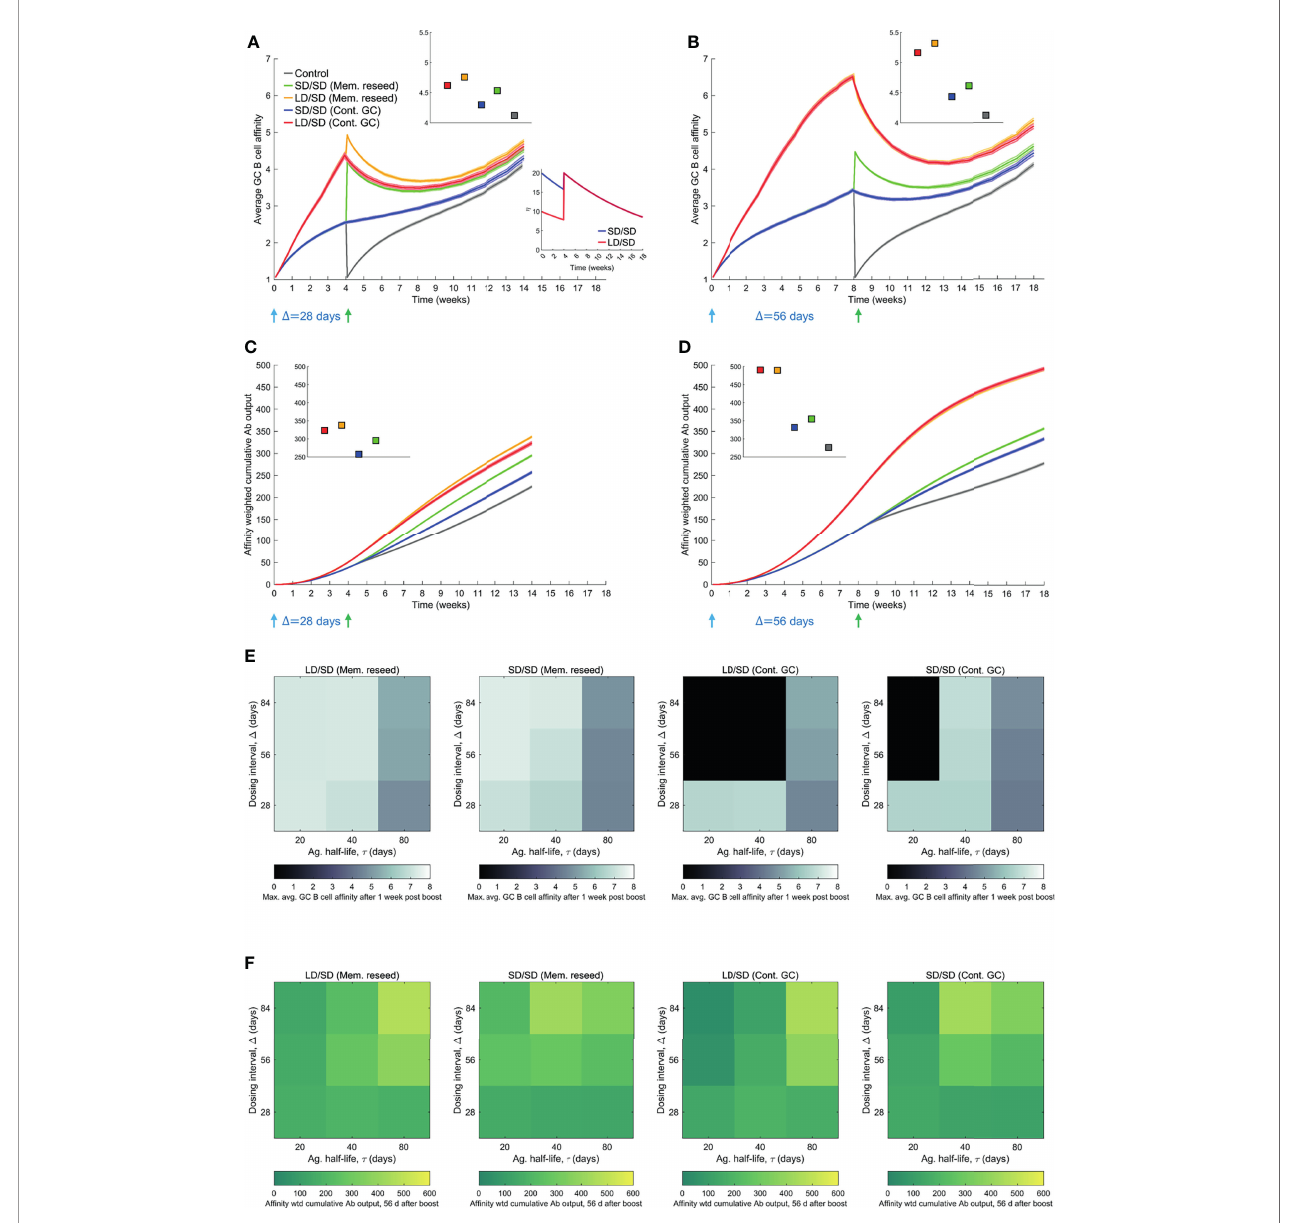
FIGURE 4 | In fl uence of prime-boost dosing interval. (A, B) Average GC B cell af fi nities, and (C, D) af fi nity-weighted Ab outputs, with prime-boost intervals ( D ) of either 28 d (A, C) or 56 d (B, D) , and with LD/SD or SD/SD dosing. Bottom inset of (A) : LD and SD correspond to h 0 = 10 and 20, respectively, with t =80 d. Top insets in (A – D) : values at the fi nal time point. Heatmaps of (E) the maximum GC af fi nity recorded between 1 week post boost administration and the fi nal time point, and (F) the af fi nity-weighted cumulative Ab output 28 d post the boost, as a function of t (20, 40 and 80 d) and D (4, 8, and 12 weeks) for the two limiting scenarios (Mem. reseed and Cont. GC). Trajectories corresponding to the heatmaps are shown in Supplementary Figure 8 . Black regions in (E) correspond to collapsed GCs. A heatmap of the af fi nity-weighted cumulative Ab output 56 d post the boost is shown in Supplementary Figure 8C